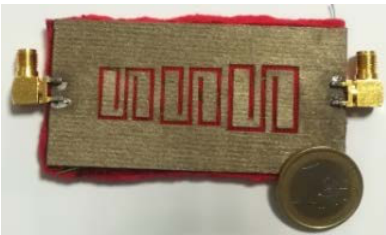
Figure 5. Picture of the multi-stopband structure. c (cid:13) [2019] IEEE. Reprinted, with permission, from [19].